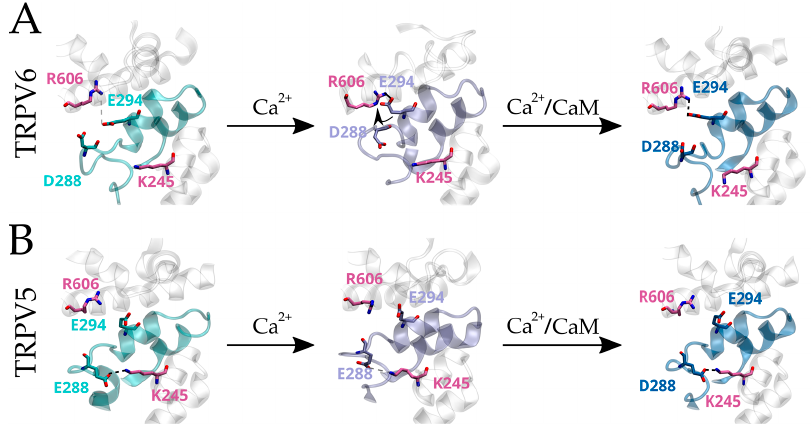
Figure 6. Proposed mechanism of fast inactivation modulation by the HLH in mammalian TRPV6 channels. Conformational changes induced by Ca 2+ ions and the binding of the Ca 2+ /CaM complex to mammalian TRPV5 and TRPV6 channels. ( A ) Structural rearrangements bring closer the HLH (i.e., E294, blue) to the TDh (i.e., R606, mauve) in TRPV6. ( B ) In mammalian TRPV5, an interaction between the HLH (E288, blue) and the ARD (K245, pink) remains constant in every state, preventing the association between the HLH and TDh.